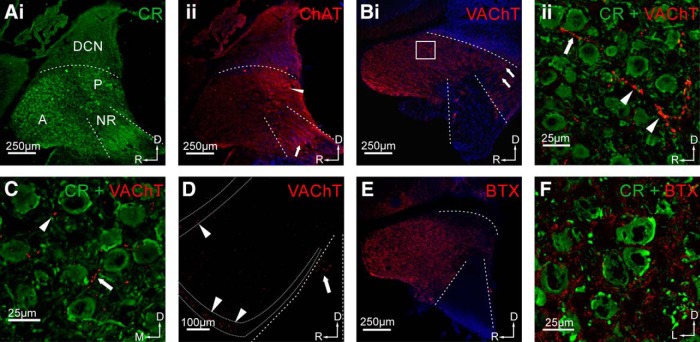
Cholinergic innervation of the CN of the gerbil. Ai, CR staining was used to distinguish CN subdivisions (A = AVCN, P = PVCN, NR = nerve root). SBCs can be indirectly identified by visualization of their large somatic, CR-positive synaptic endbulb of Held terminal. Aii, Staining with anti-ChAT showed immunolabeling in all subdivisions of the CN, with increased signal intensity in the PVCN (arrowhead) and immunolabeling of cholinergic fibers arranged in stripes in the auditory nerve region (arrow). Scale bar, 250 µm. Bi, Staining with antibodies against the VAChT showed strong immunolabeling in the AVCN and PVCN. This staining also revealed VAChT-positive fibers with en passant swellings (white box in AVCN; arrows in PVCN). Bii, The z-projection of a high-magnification confocal stack recorded at the site indicated by the white square in Bi, double staining with CR and VAChT. VAChT-positive fibers (arrow) pass through the neuropil between SBCs forming en passant swellings (arrowheads). Scale bars: Bi, 250 µm; Bii, 25 µm. C, Confocal image of a frontal section of the AVCN, double stained with CR and VAChT. In this cutting plane, only few tangentially oriented labeled fibers were observed (arrow); instead, single puncta-like signals were present. Scale bar, 25 µm. D, VAChT staining in a sagittal VCN section with demarcation of the granular cell domain (region between dotted lines). Note the stronger VAChT signals in GCD (arrowheads) compared with the rest of the AVCN. VAChT signals can also be seen in the auditory nerve root (arrow). Scale bar, 100 µm. E, Staining with Alexa Fluor-conjugated α-BTX yielded homogeneous distribution of BTX signals in the AVCN and the region of the auditory nerve root being left blank. F, High-magnification confocal image of CR and BTX double staining in the AVCN showed punctate signals in the neuropil surrounding the SBC. Scale bars: i, 250 µm; ii, 20 µm. Orientation of slices: D = dorsal, R = rostral, M = medial, L = lateral (applies to all images).